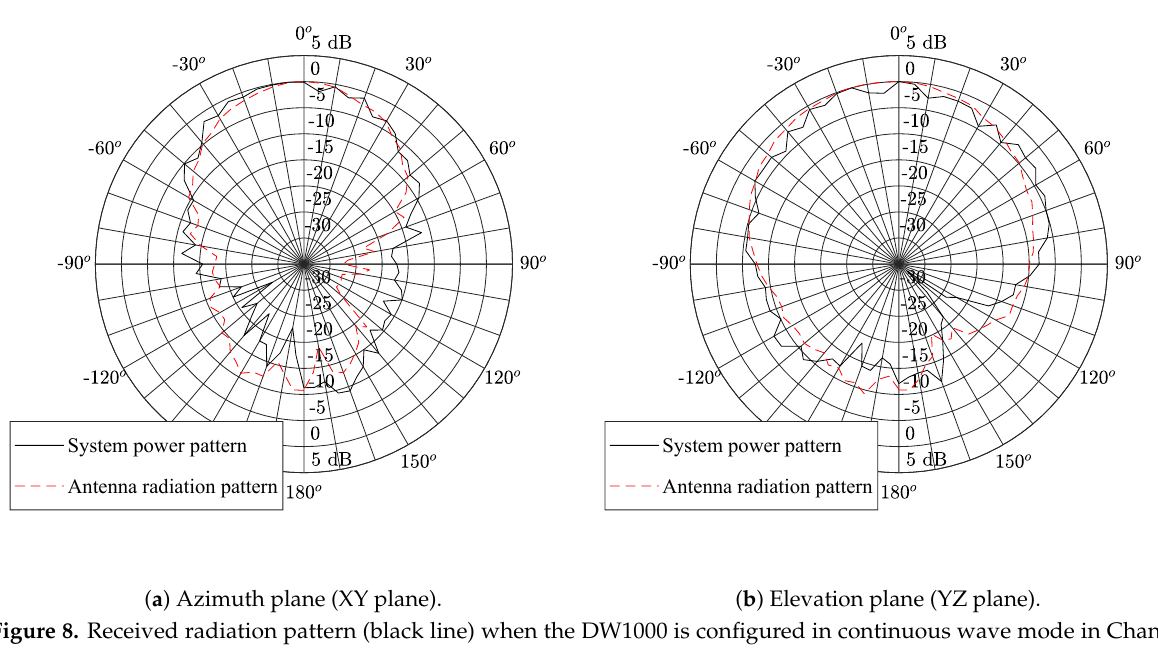
Figure 8. Received radiation pattern (black line) when the DW1000 is configured in continuous wave mode in Channel 2 overlayed with the measured radiation pattern published in [26] (dashed red line). For comparison, both patterns are normalized to 0 dB broadside